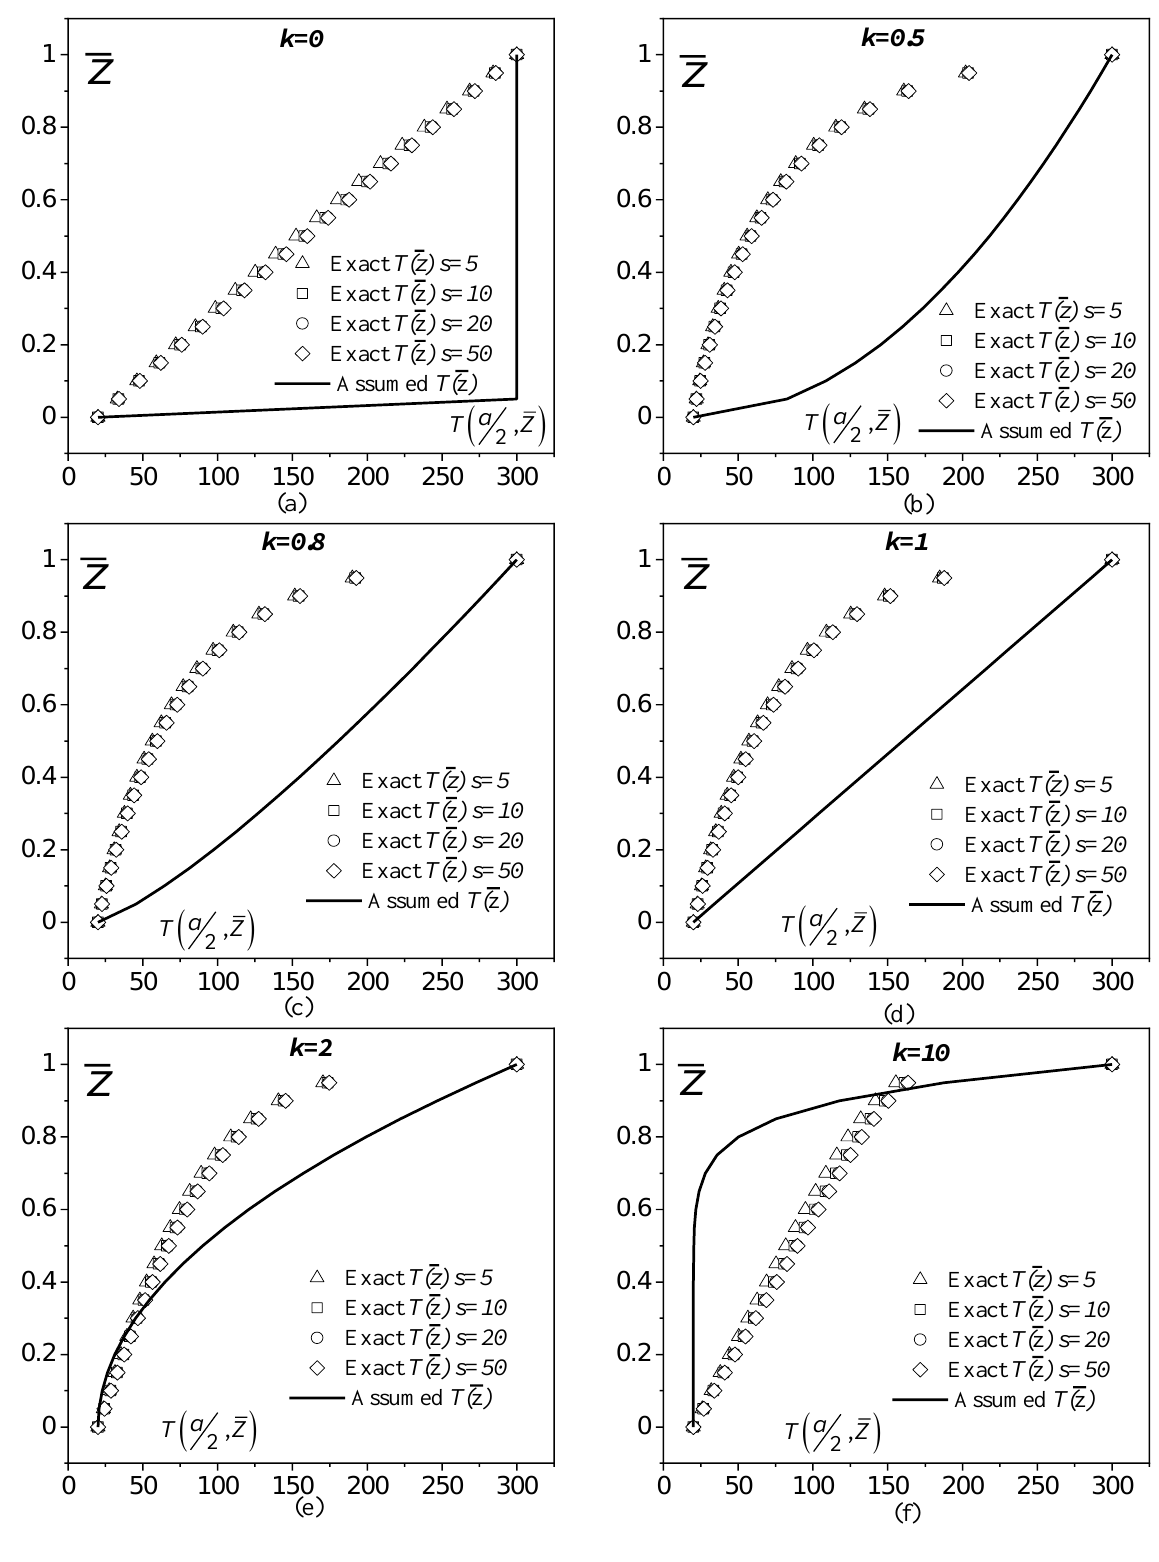
Fig. 3. Comparison between through thickness exact temperature variation and power law variation for various power index ( k) of FG laminate [Material set